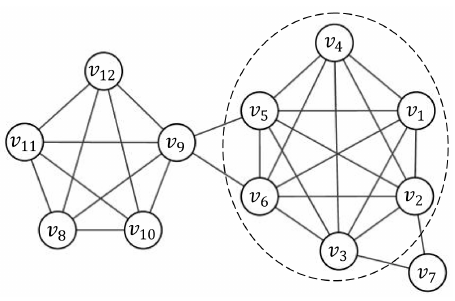
Figure 1. An example network. Although node v 2 , v 5 and v 9 have the same degree, they have different representability to a subgraph from Equation (5).